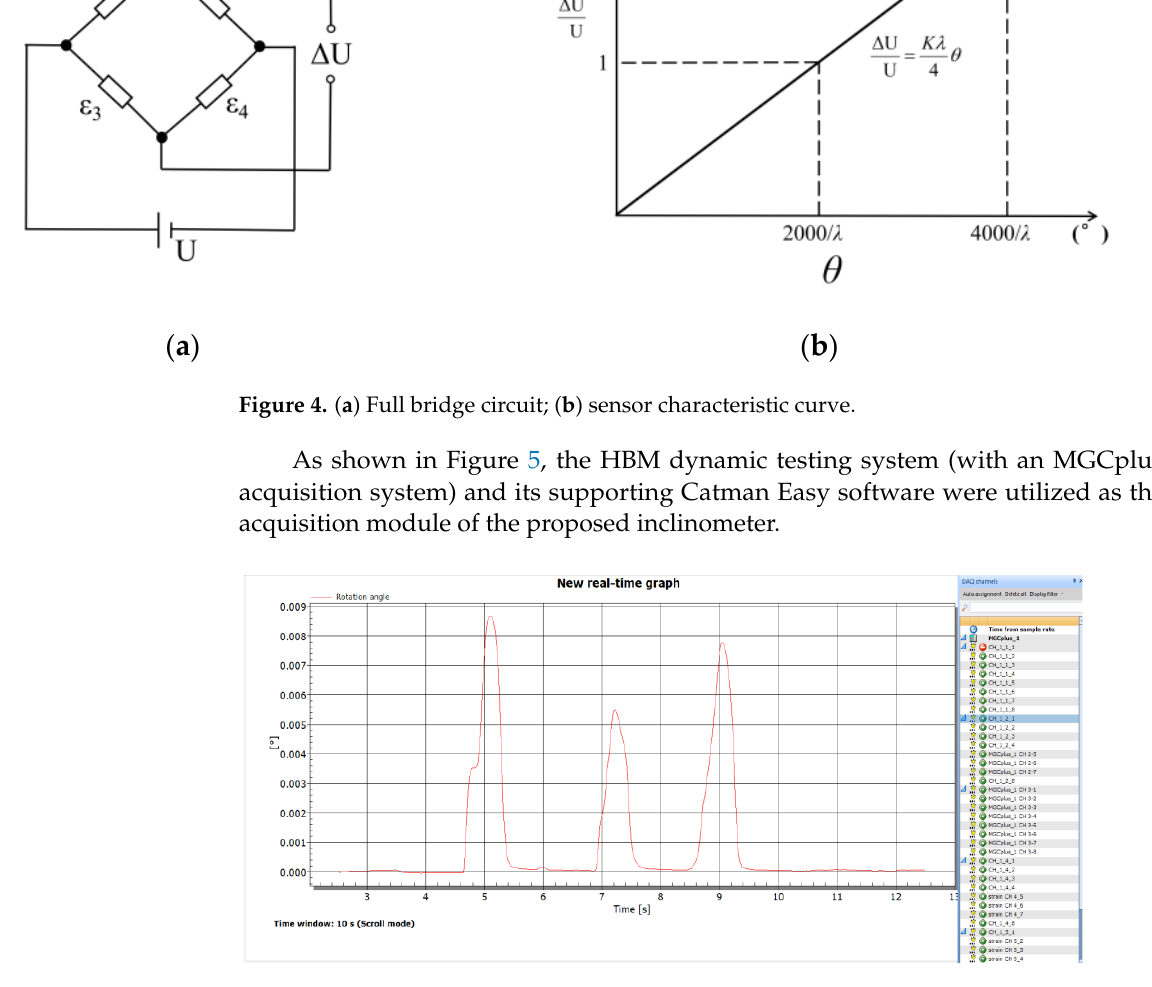
Figure 5. Data acquisition module interface.